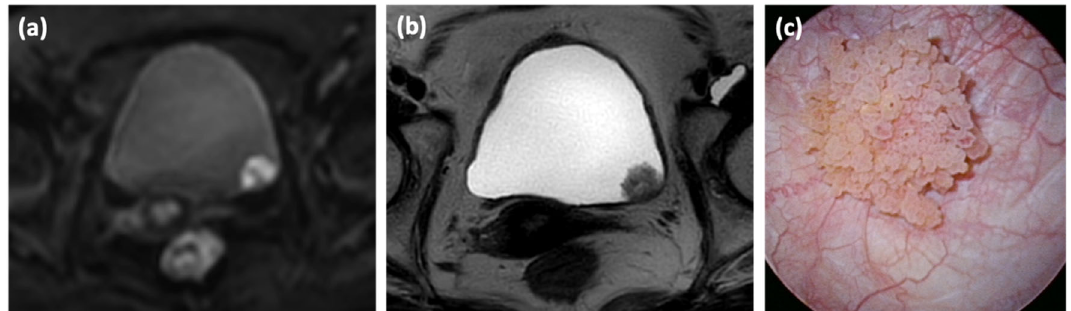
Figure 1. The case of bladder cancer with inchworm sign. Findings of bladder cancer in a 72-year-old woman diagnosed with hematuria. ( a ) Diffusion-weighted (DW)-MRI shows high signal intensity from the tumor and low signal intensity from the submucosal stalk. This finding is defined as the inchworm sign. ( b ) Transverse T2-weighted MRI shows a tumor on the left lateral wall of the bladder; however, no change in the internal signal intensity is observed. ( c ) Cystoscopy reveals a papillary tumor at the same